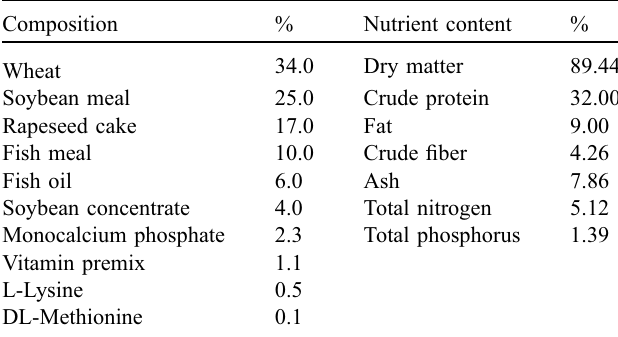
Table 1. Composition and calculated nutrient content of the formulated feed supplied from April 14 to November 2,